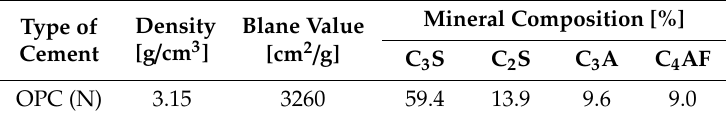
Table 2. Mineral composition and physical property of the cement used in the adiabatic mass temperature rise tests [23].